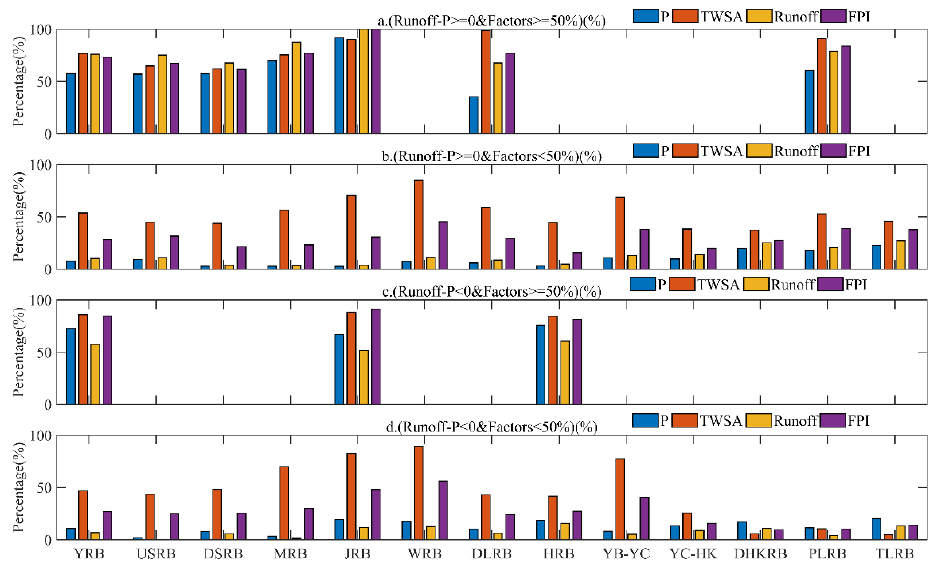
Figure 8. Different cases for the percentile of runoff, precipitation, FPI and TWSA compared to 50% for the positive and negative value of runoff minus precipitation in the YRB during April 2002– December 2019. (( a – d ) are the cases for the percentile of runoff minus precipitation no less than 0 and factors no less than 50, the percentile of runoff minus precipitation no less than 0 and factors less than 50, the percentile of runoff minus precipitation less than 0 and factors no less than 50, and the percentile of runoff minus precipitation less than 0 and factors less than 50, respectively).